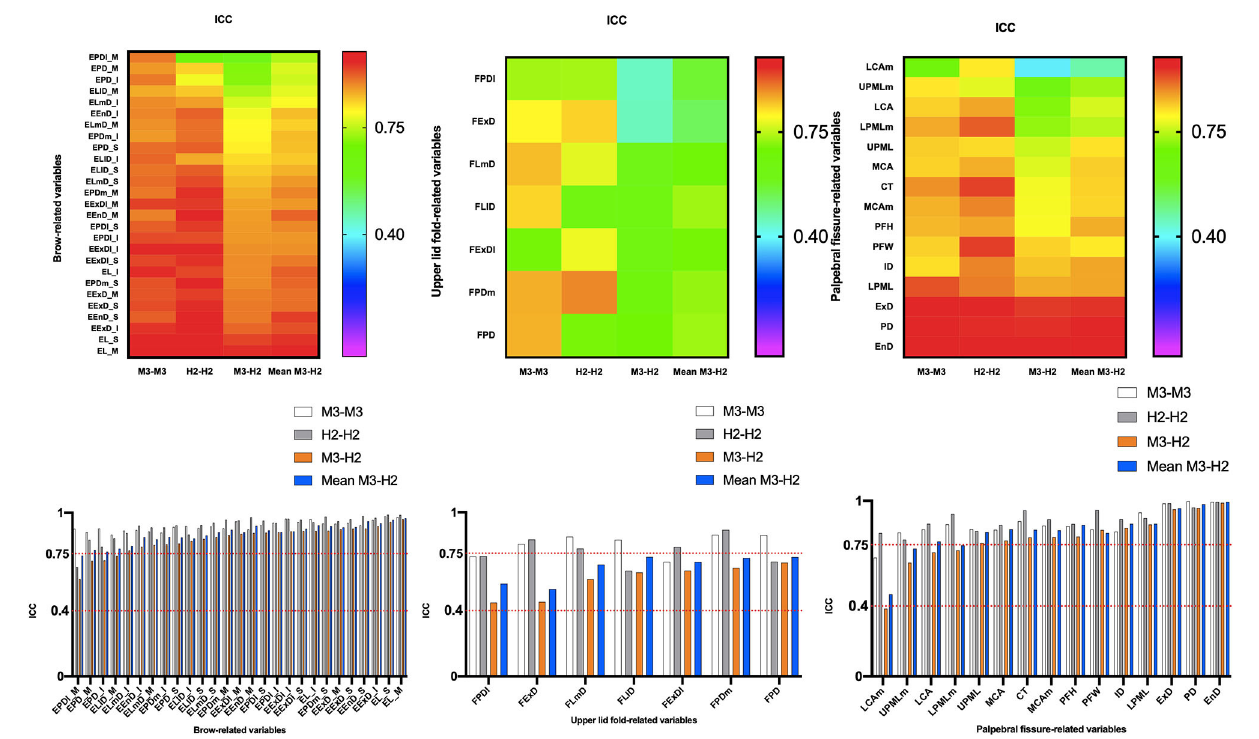
FIGURE 3 | Intra- and inter-device of intraclass correlation coefficient (ICC) for all periocular region measurements of 3D images. ICC values allowed the classification of the agreement into three classes: < 0.4, poor agreement; 0.4–0.75, satisfactory; and ≥ 0.75, excellent.